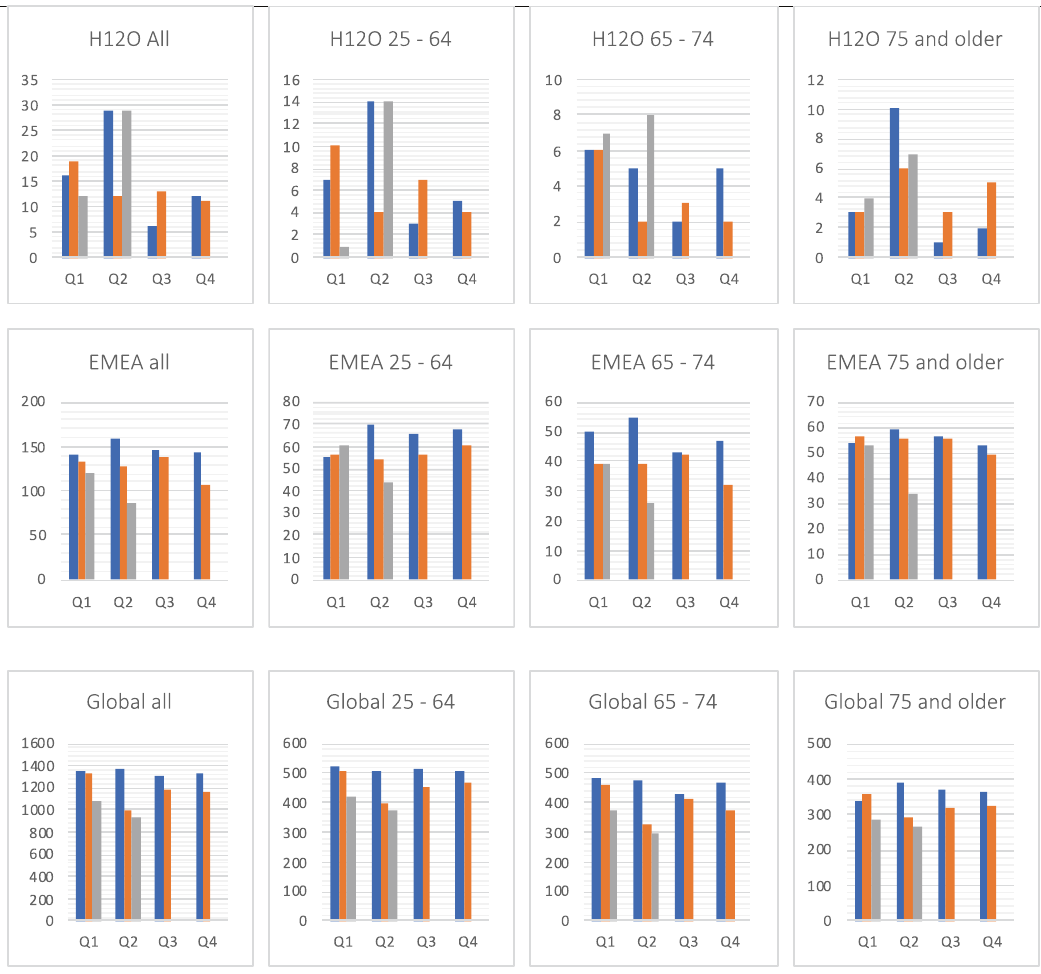
Fig. 2 New MM cases by year. New cases of MM by data network, age group and quarters of 2019 (blue), 2020 (orange) and 2021 (gray).